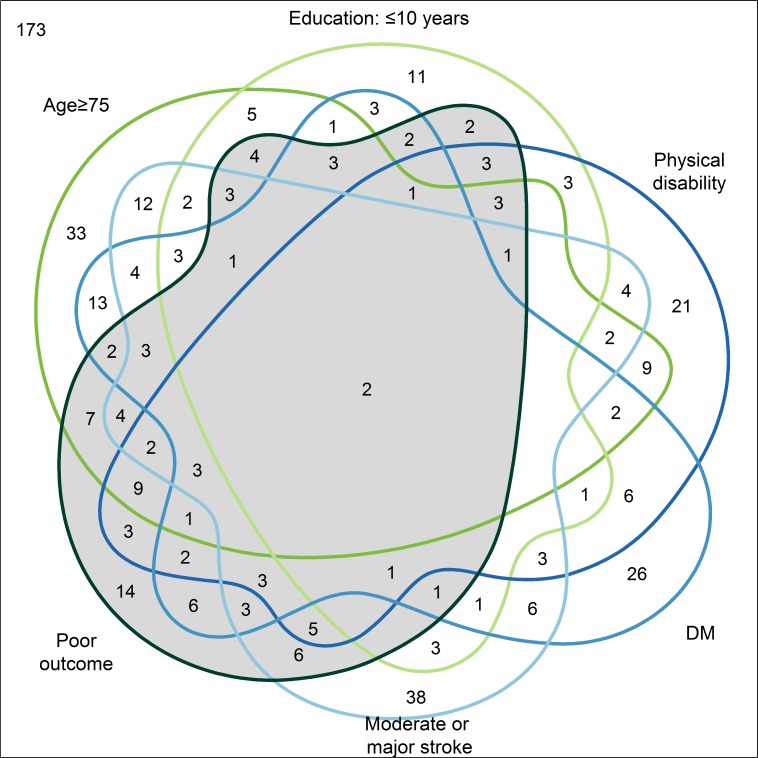
Venn diagram illustrating the intersections of the independent predictors and poor outcome 12 months after stroke.